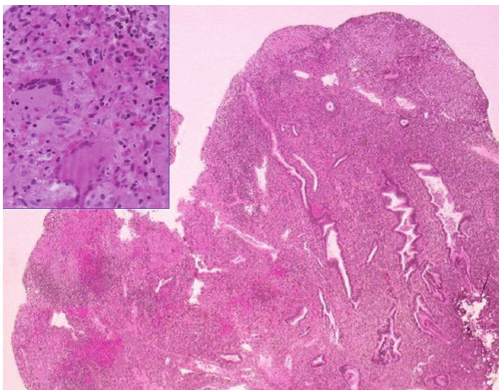
Figure 1: Pathological examination of the endometrial polyp. Microscopic analysis of the surgically removed endometrial polyp showed superficial erosive inflammation with numerous nonnecro- tizing granulomas containing Langhans giant cells. No acid fast organism was seen on Ziehl-Neelsen